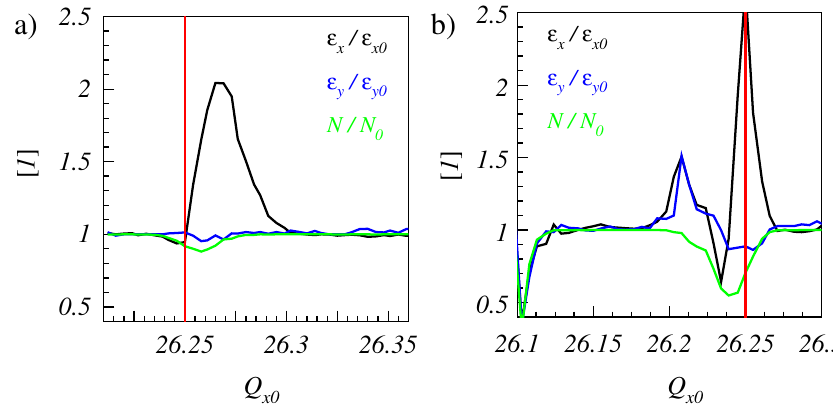
FIG. 9. (Color) Octupolar resonance: space-charge-induced emittance increase and beam loss (left); electron-cloud-induced emittance increase and beam loss (right). In both cases we apply 21 SC or EC ‘‘kicks’’ per betatron wavelength and synchrotron motion is ¼ 26 : 1 included. In all these simulations Q y 0